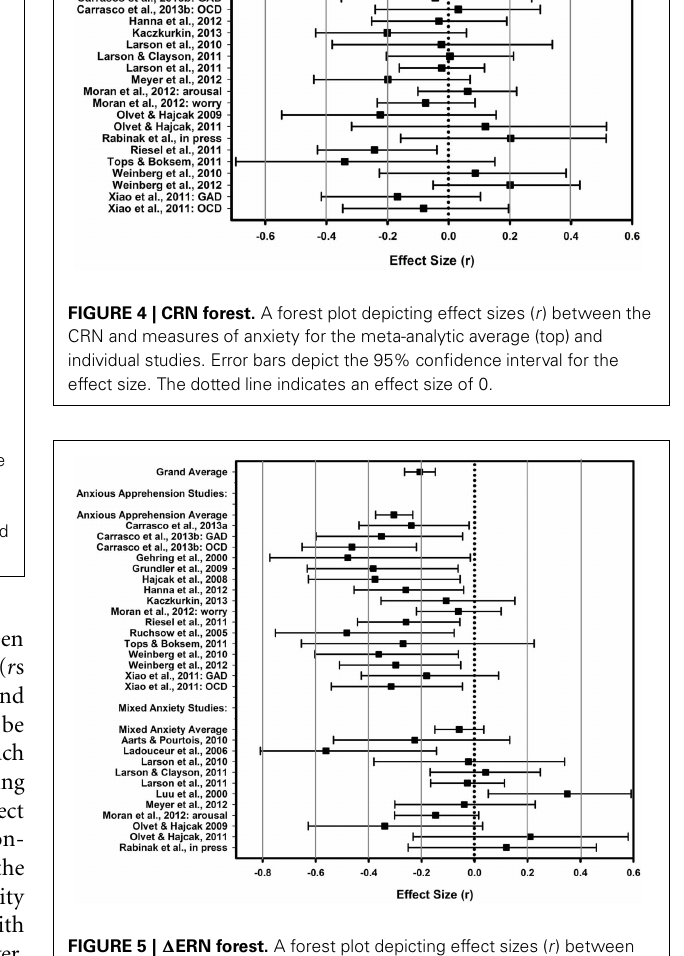
FIGURE 5 | (cid:2) ERN forest. A forest plot depicting effect sizes ( r ) between the (cid:2) ERN and measures of anxiety for the meta-analytic average (top), the anxious apprehension and mixed anxiety averages, and individual studies. Error bars depict the 95% confidence interval for the effect size. The dotted line indicates an effect size of